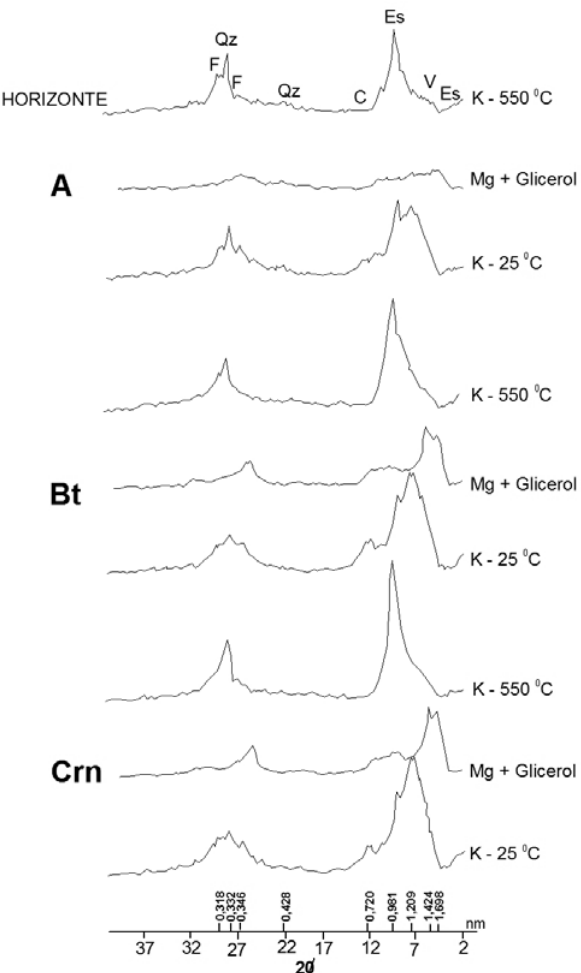
Figura 4. Difratograma de raios X da fração argila do perfil 3, Planossolo Háplico Sálico solódico. C: caulinita; F: feldspato; Qz: quartzo; Es: esmectita; V: vermiculita.